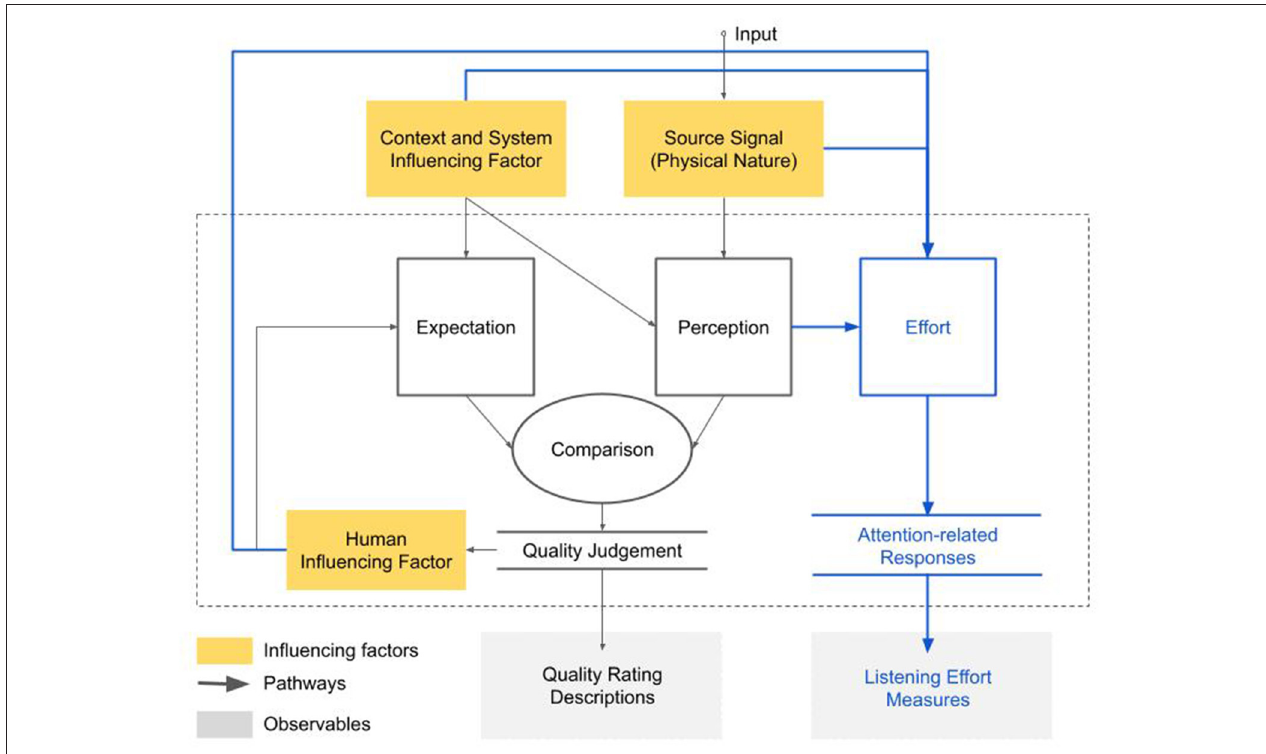
FIGURE 1 | The QoE framework adapted from the QoE whitepaper (Brunnström et al., 2013) where the QoE formation pathways (lines with arrows), the QoE observables (gray boxes), and the QoE influencing factors (orange boxes) are identified. The elements in the existing framework are denoted in black and the expanded parts are in blue. The existing model assumes that the QoE is the outcome of comparing the expected event and the perceived event (see the mechanistic diagrams in black). Both expectation and perception are influenced by different influencing factors. The influencing factors are grouped to four categories (orange boxes). The perceived quality is observed by the subjective rating and/or description of an event (gray box at the